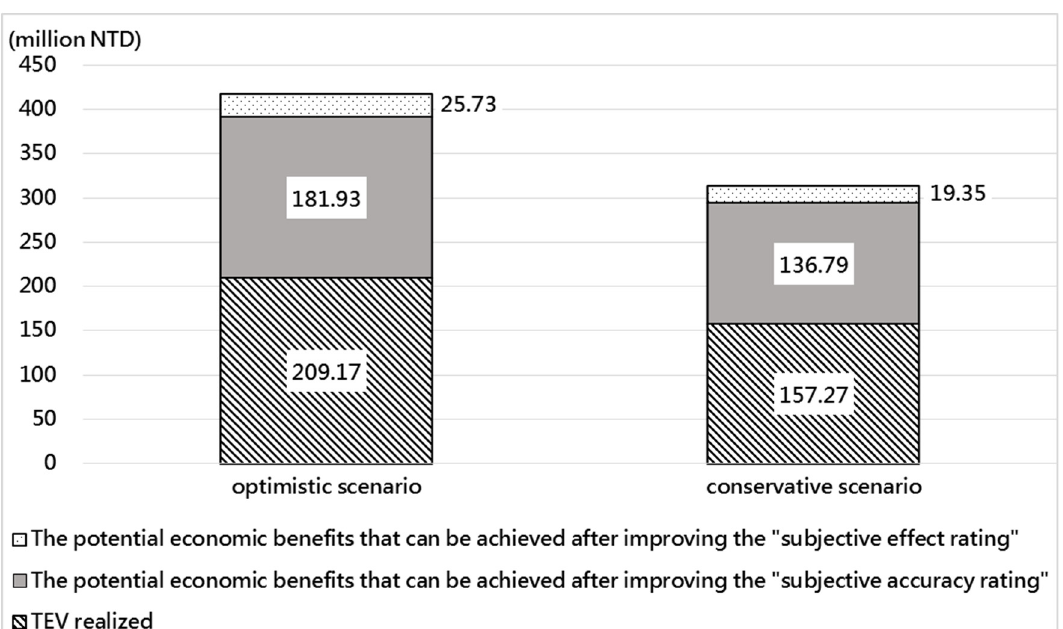
Figure 1. The value of meteorological information realized and to be realized under optimistic and conservative scenarios.